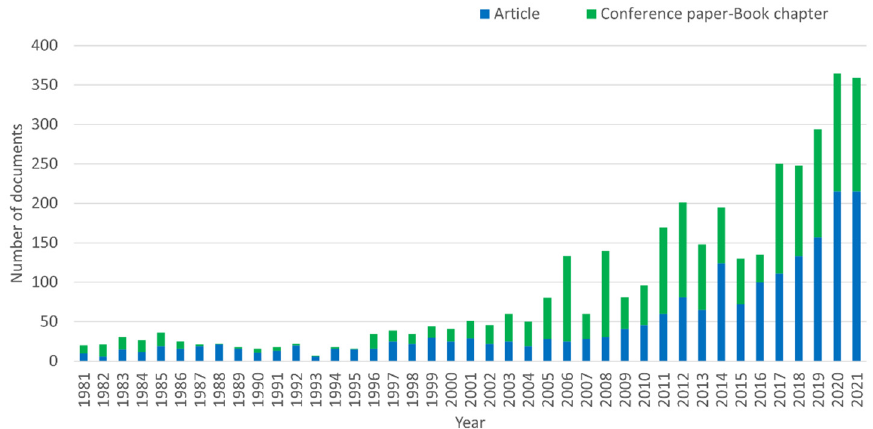
Figure 2. Trends in publications on greenhouse engineering from 1981 to 2021. The histogram represents the number of articles published in indexed journals with respect to other papers reported in conference proceedings and book chapters.